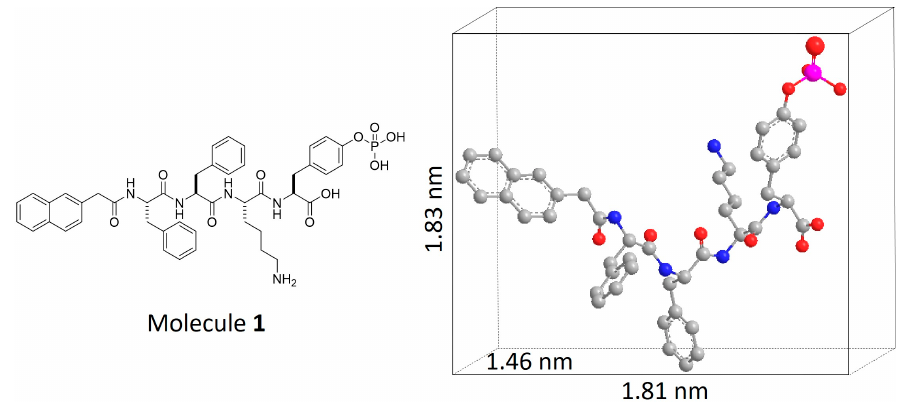
Scheme 1. Structure of molecule 1 (chemical name: (2 S ,5 S ,8 S ,11 S )-5-(4-aminobutyl)-8,11-dibenzyl-14- (naphthalen-2-yl)-4,7,10,13-tetraoxo-2-(4-(phosphonooxy)benzyl)-3,6,9,12-tetraazatetradecanoic acid) and its physical dimension. Molecular dimensions are indicated by a box enclosing the molecule. Grey: carbon; Red: oxygen; Blue: nitrogen; Purple: phosphorus while hydrogen is omitted.